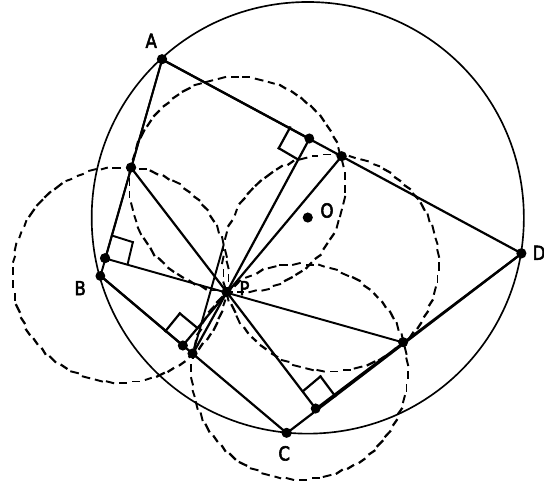
Figure 6: Nine-point centre of a cyclic quadrilateral Then as shown in Figure 7, we have the interesting generalisation of the Euler line, namely, that the circumcentre O , nine-point centre P , and centroid G of a cyclic quadrilateral are not only collinear, but also OG = GP (for a proof, see De Villiers, 1999).